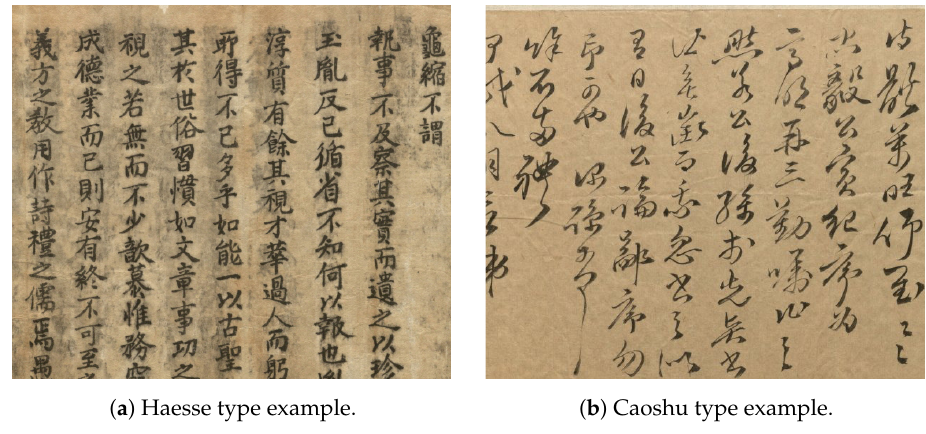
Figure 1. Examples of Chinese character